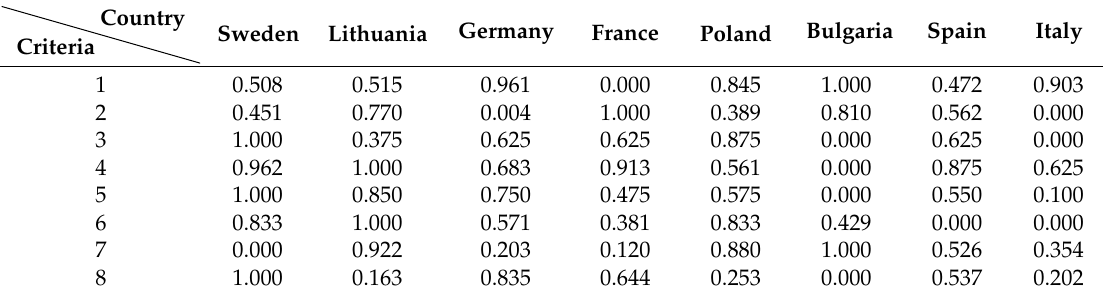
Table 8. Normalized values of